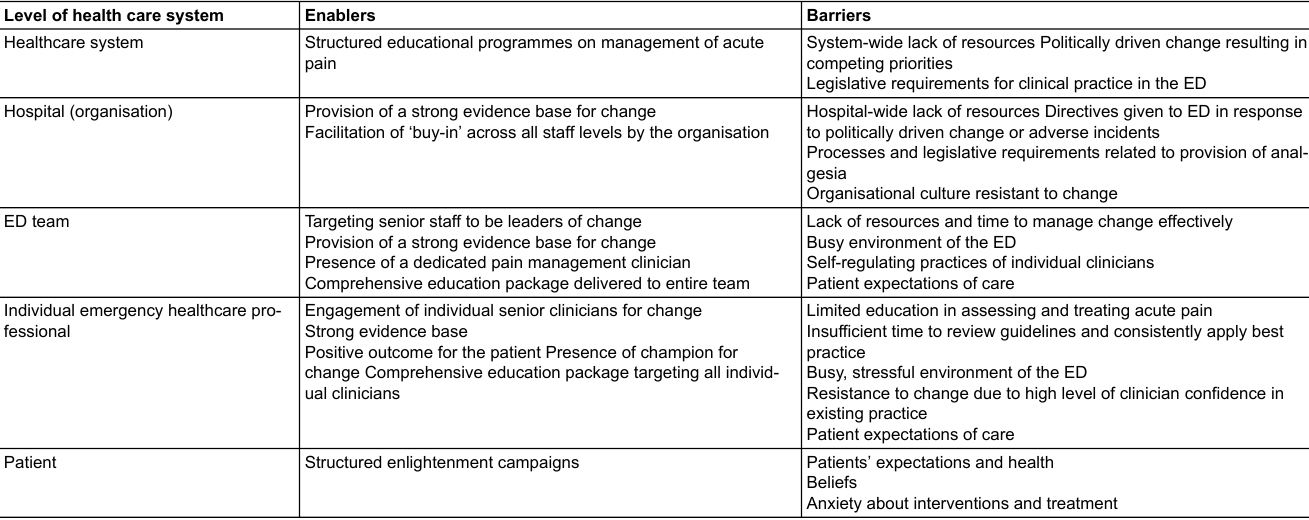
Table 1: Enablers and barriers for best practice of pain management in the emergency